Question: What visual encoding does this figure use to show its data?
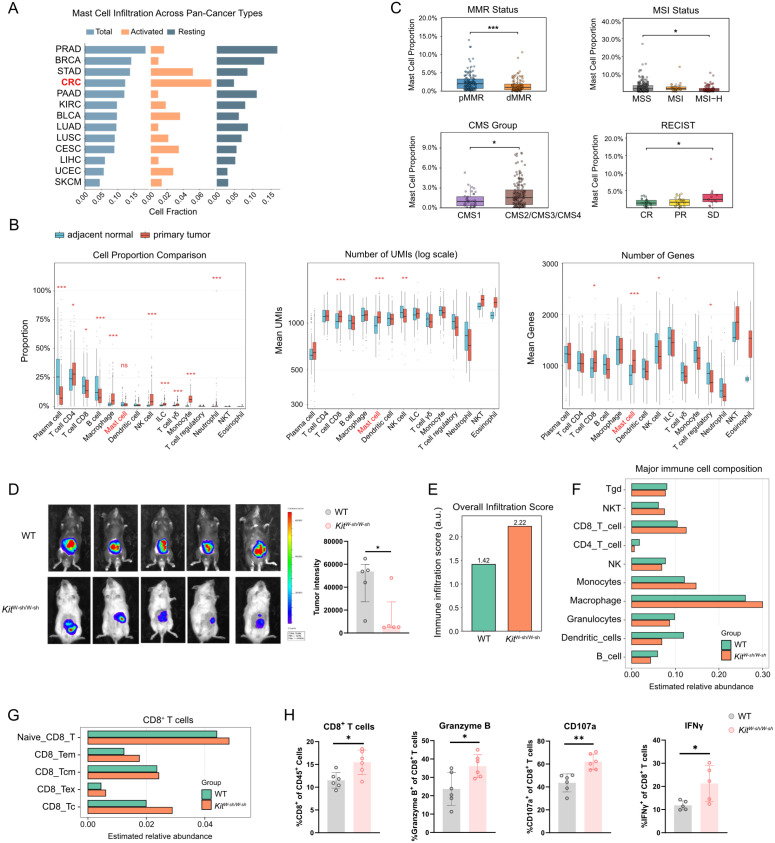
Answer: box